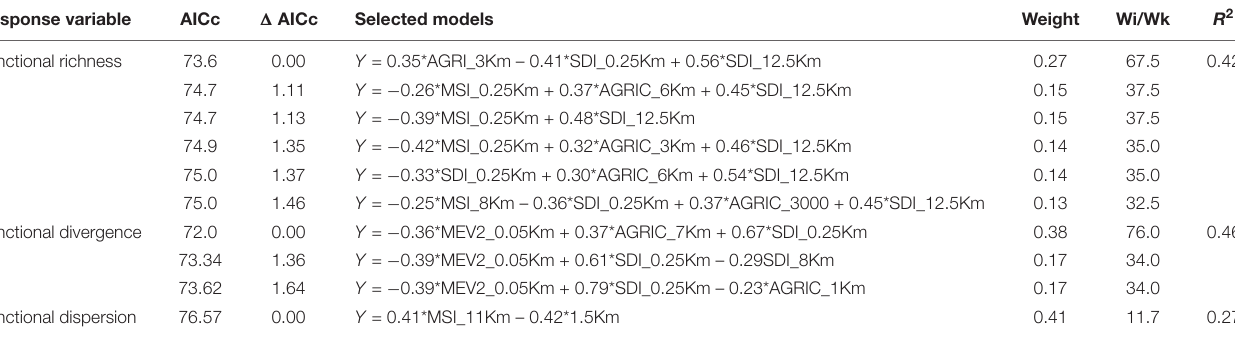
TABLE 2 | Overview of minimal adequate models describing landscape and local effects on functional richness, functional divergence, and functional dispersion of bees in agricultural landscape. Response variable AICc (cid:49) AICc Selected models Weight Wi/Wk R